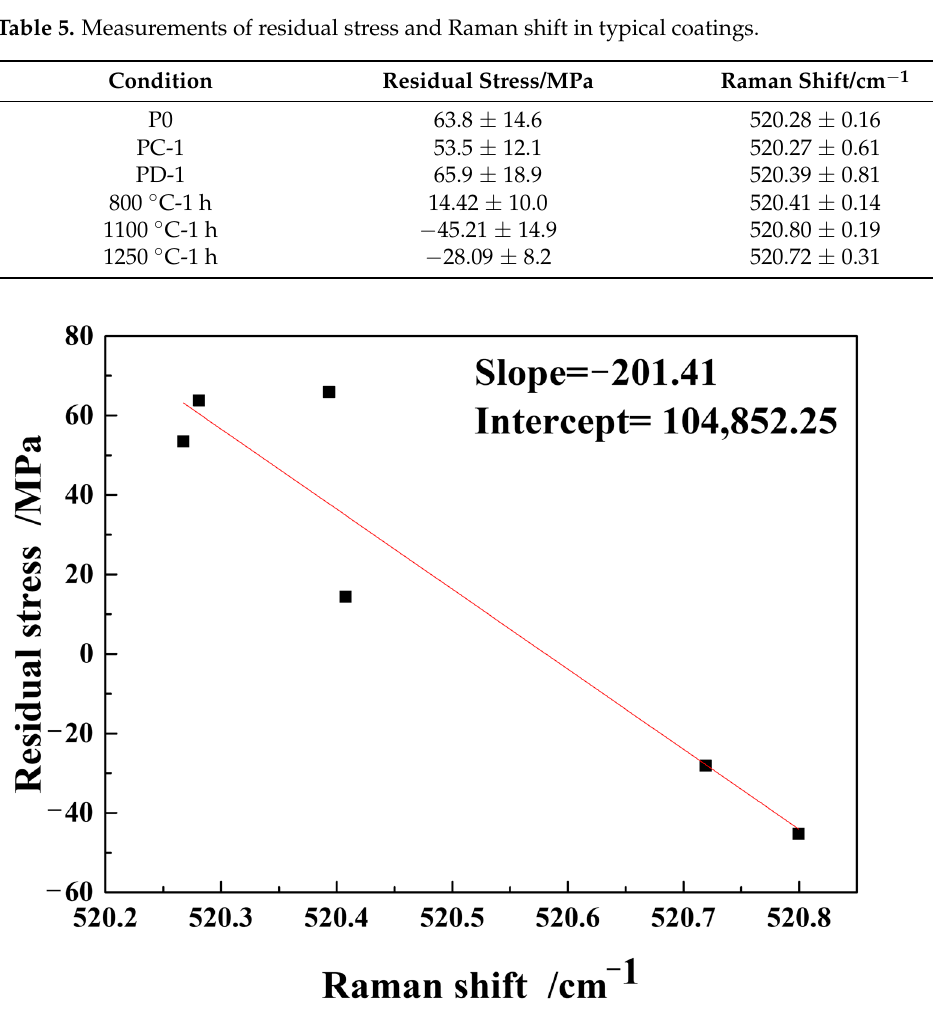
Figure 11. Results of residual stress–Raman shift and linear fi tt ing.